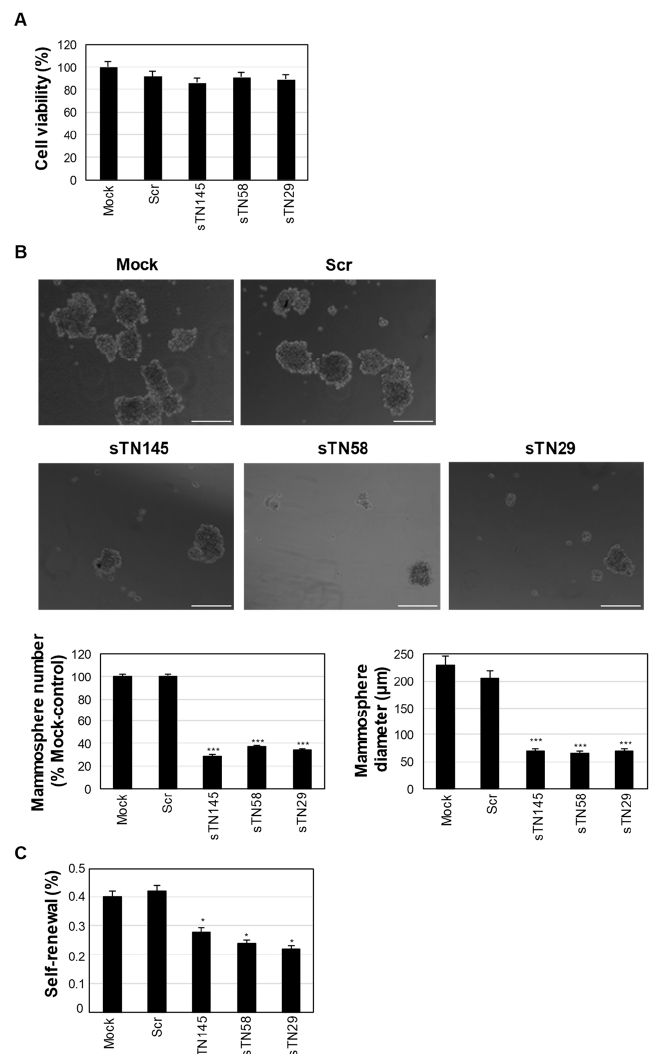
Figure 7. Effect of sTN145, sTN58 and sTN29 aptamers on mammosphere-forming efficiency of MDA-MB-231 cells. ( A ) Viability of MDA-MB-231 cells mock-treated or treated with the indicated aptamers for 24 h. Data are expressed as a percentage of viable treated cells with respect to mock- treated cells. ( B ) Representative phase-contrast images of MDA-MB-231 cells, previously treated for 24 h with sTN145, sTN58, sTN29 or Scr, after 10 days of growth in stem-permissive conditions. Magnification 10×, scale bar = 200 μ m. Cell treatment with the short TNBC aptamers, but not the Scr, inhibits both the number, expressed as a percentage with respect to mock-control cells (left) and diameter (right) of mammospheres. ( C ) Mammosphere self-renewal capacity is expressed as a number of secondary mammosphere population (P1)/cell-seeded × 100. ( A – C ) Bars depict mean ± SD of three independent experiments. In ( B ) and ( C ), *** p < 0.001; * p < 0.05 relative to mock-control cells. No statistically significant variations between Scr and mock-treatment were obtained.